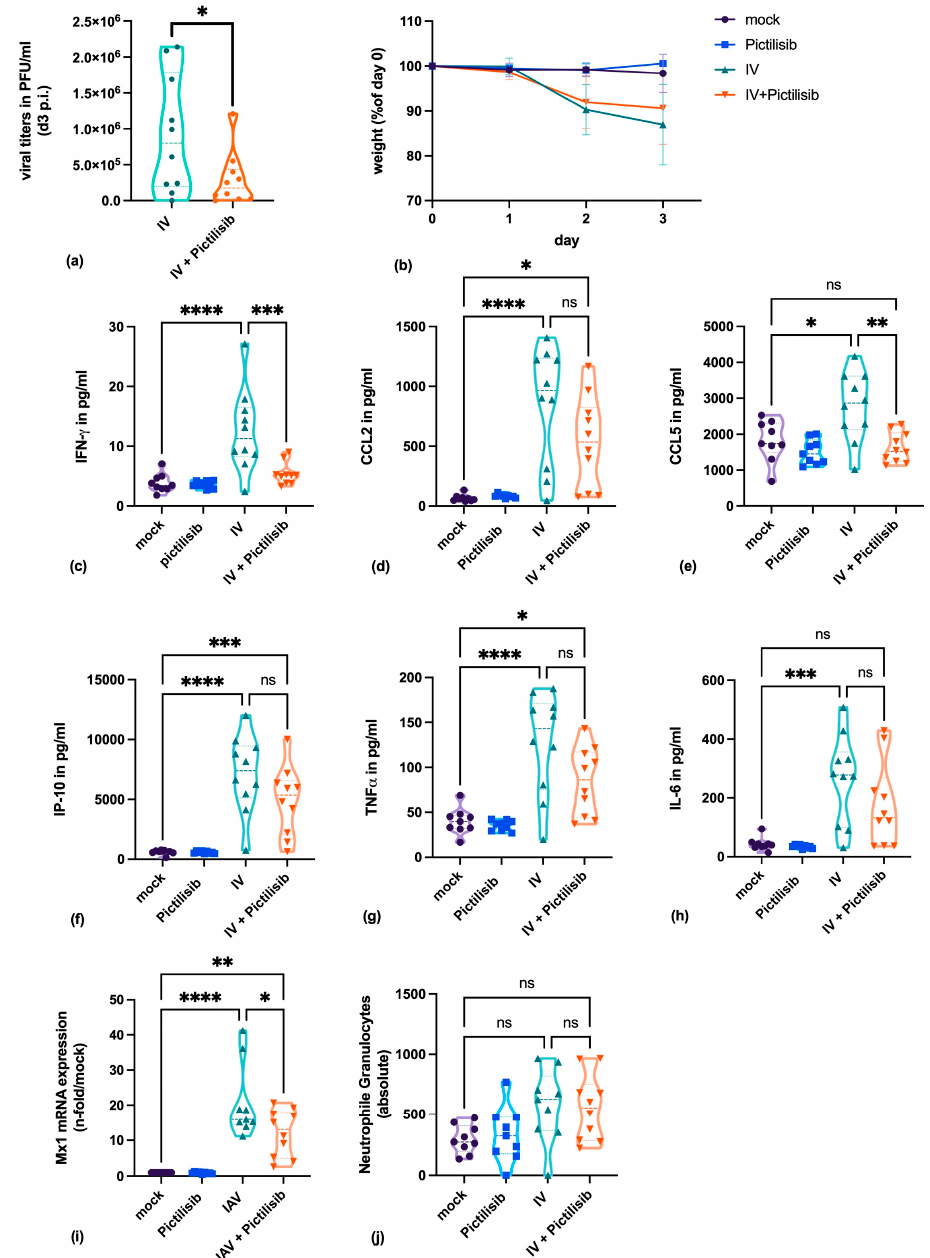
Figure 6. Pictilisib reduces virus titers and the pro-inflammatory response of IV-infected mice. ( a – j ) C57BL/6JRj mice were treated with 150 mg kg − 1 Pictilisib on day 0 and infected with IV variant HA-G222-mpJena/5258 followed by further Pictilisib treatment on day 1 and 2 after infection. Three days post infection (p.i.) mice were sacrificed to subject blood samples and lung explants. Viral titers ( a ), body weight of mice ( b ), and the secreted pro-inflammatory cytokines and chemokines ( c – h ; IFN- γ , CCL2, CCL5, IP-10, TNF- α , IL-6), Mx1 mRNA expression ( i ) and number of neutrophil granulocytes ( j ) are depicted for achievable interpretation of Pictilisib treatment in mice. Statistical analysis was performed by one-way ANOVA followed by multiple comparisons test. (ns = not significant, **** p < 0.0001, *** p < 0.001, ** p < 0.01, * p <